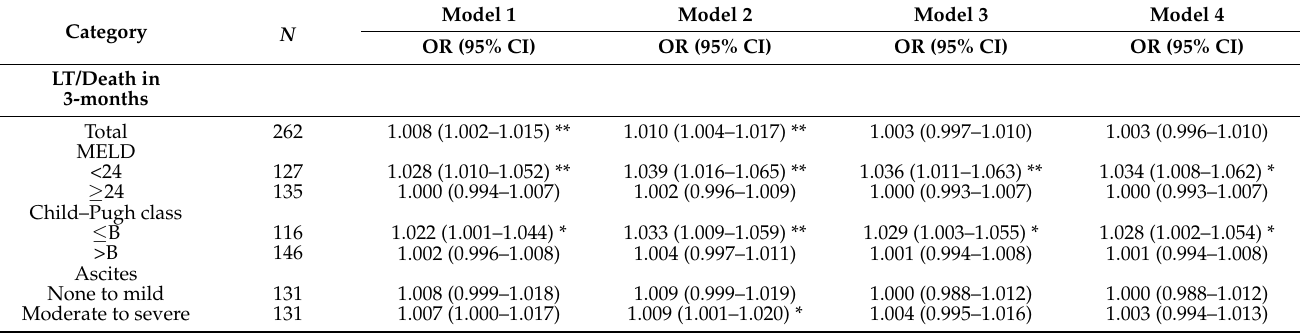
Table 3. Multivariate analysis of the effect of urine NAG on the incidence of